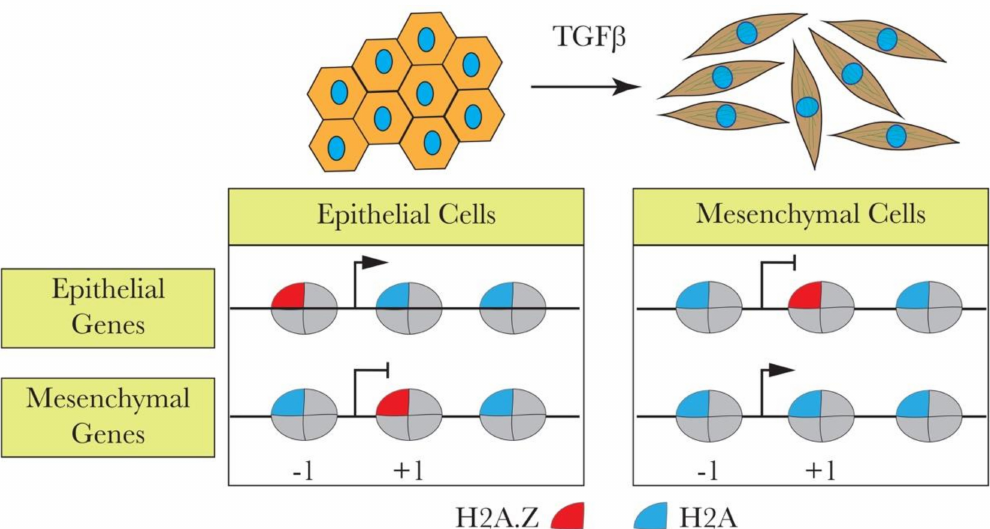
Figure 1. H2A.Z is associated with transforming growth factor beta (TGF β )-induced epithelial- to-mesenchymal transition (EMT). TGF β induces EMT by leading to H2A.Z loss from the epithelial and mesenchymal promoters, causing the up- or downregulation of the genes. The loss of H2A.Z from the -1 nucleosome in epithelial genes downregulates these genes. On the other hand, the loss of H2A.Z from + 1 nucleosomes upon TGF β induction upregulates mesenchymal